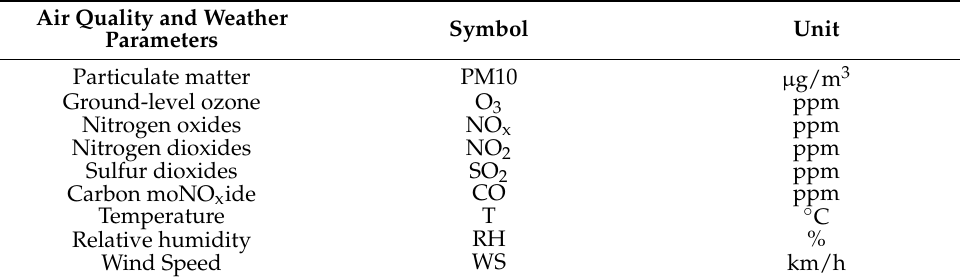
Table 2. Air quality